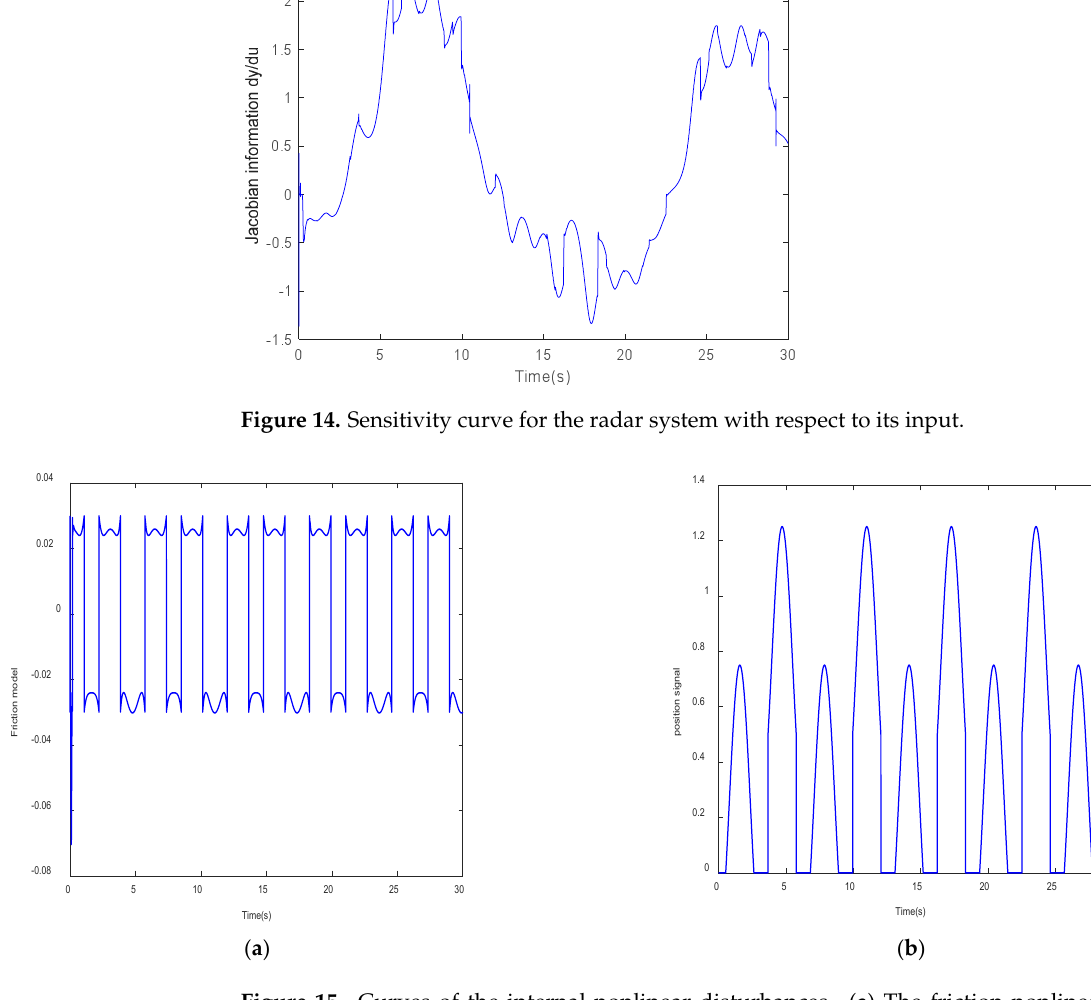
Figure 15. Curves of the internal nonlinear disturbances. ( a ) The friction nonlinearity, ( b ) The dead zone.